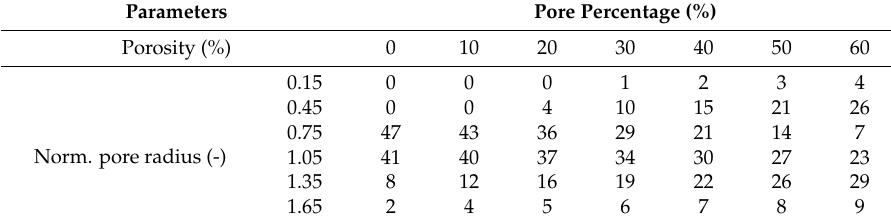
Figure 5. The indirectly reconstructed lotus-type cross-sections with different porosities and their corresponding pore percentages. Table 2. Interpolated and extrapolated pore percentages for various porosities.